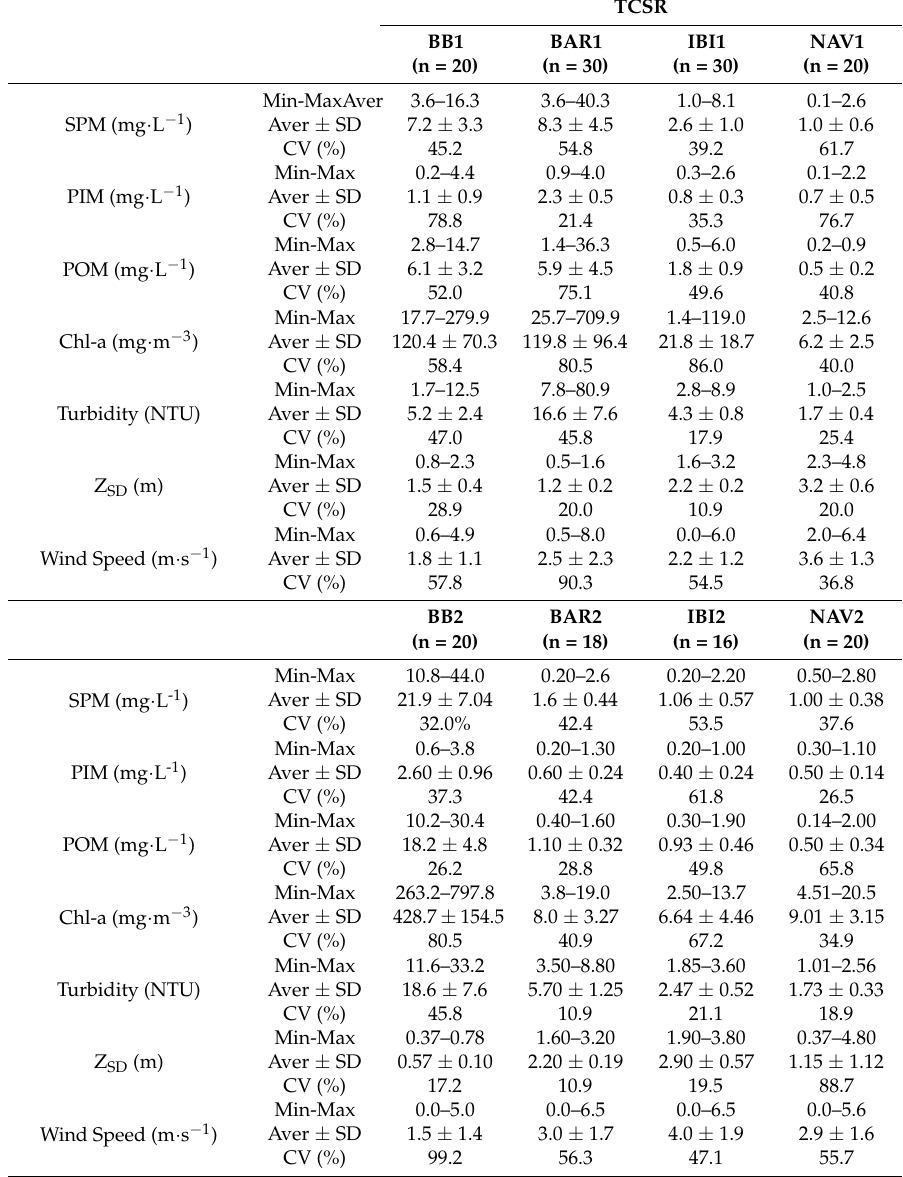
Table 4. Descriptive statistics from all field campaigns carried out in TCSR. The notations represent: SPM—Suspended Particle Matter, PIM–Particle Inorganic Matter, POM—Particle Organic